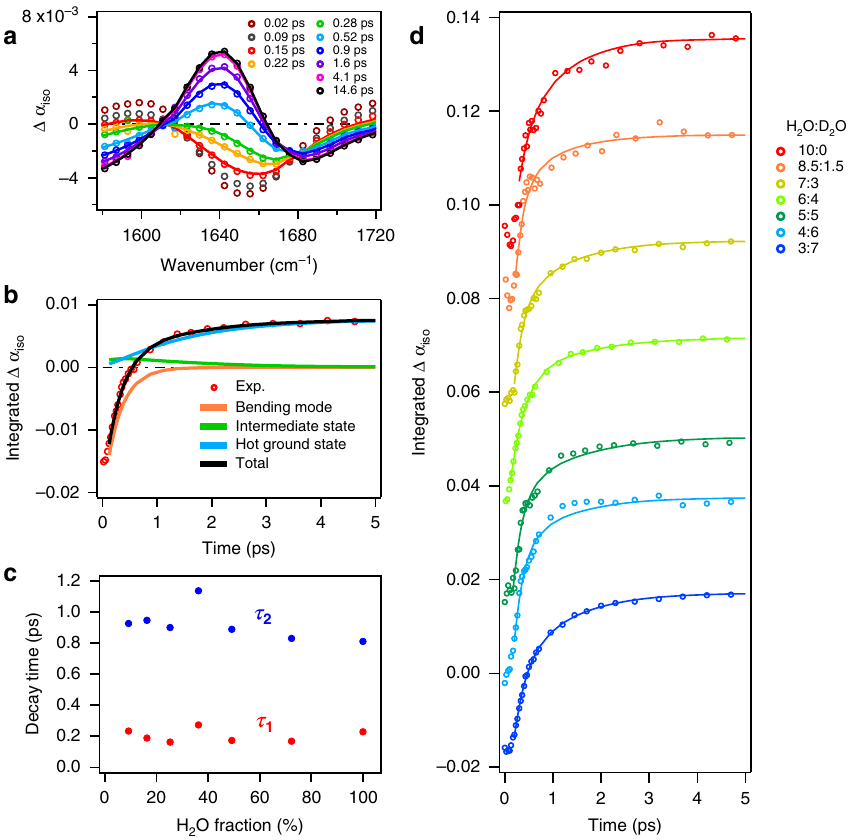
Fig. 3 The isotropic transient absorption of various isotopic compositions. a Transient absorption spectra of water bending mode for H 2 O:D 2 O = 6:4. The four-state model fi t the data starting at 0.15 ps. b Time evolution of the transient absorption spectra integrated at 1649 cm − 1 < ω < 1662 cm − 1 . The orange, green, and blue lines represent the contributions of the excited state, intermediate state, and hot ground state, respectively, to the fi t. c Isotropic relaxation times as a function of isotopic composition. The relaxation time of the excited state to intermediate state is τ 1 (red symbol) and the relaxation time of the intermediate state is τ 2 (blue symbol). d Isotropic transient signals for various H 2 O-D 2 O mixtures. The signals are normalized at t = 0. Traces are offset by increments of 0.02. Open circles in panels a , b and d represent the experimental data, while the solid lines show fi ts with the kinetic